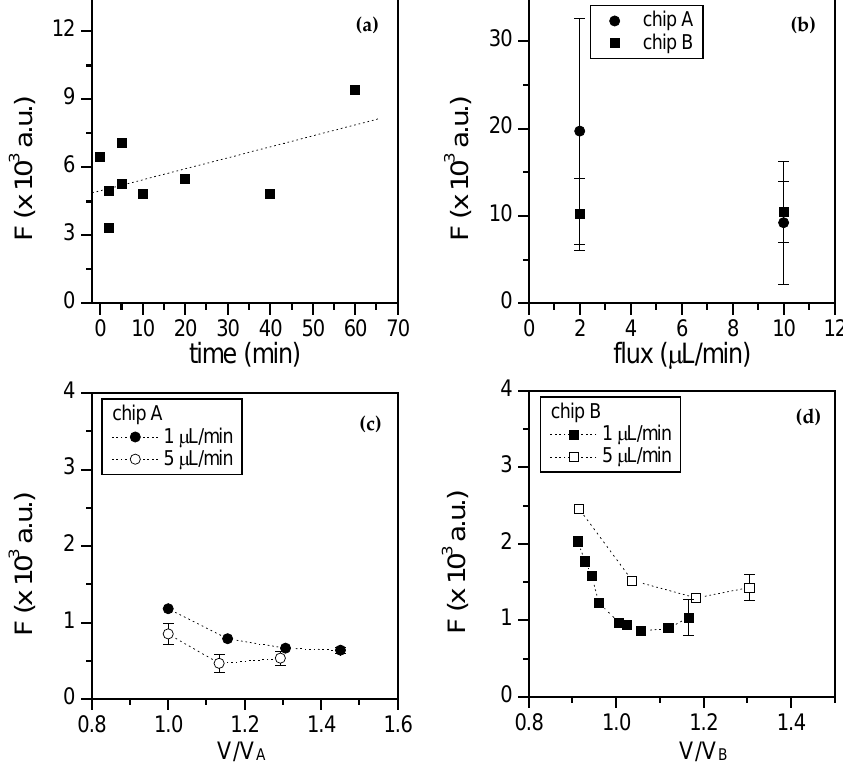
Figure 5 . Optimization of protocols from PDMS planar surfaces to spiral microdevices. Fluorescent miRNAs were used to assess functionalization parameters. Panel ( a ): optimization of silanization time. The microdevice is functionalized with a mixture of 0.1% APTMS and 0.9% PEG-s silane (named AS) in immersion at 60 °C for different times. An amount of 600 ng of fluorescent microRNAs diluted in water are then absorbed to microdevice AS surfaces and the resulting fluorescence is reported as a function of the silanization time. Panel ( b ): optimization of the flux speed during microRNA insertion. 3 ng/µL miR-1246-TAMRA was inserted either at 2 µL/min x 100 min or 10 µL/min x 20 min. Panels ( c , d ): optimization of washes speed after miR adsorption. A total of 600 ng of miR-1246-TAMRA, diluted in human plasma added with lysis bu ff er, were incubated on microdevices A (Panel ( c )) or B (Panel ( d )); then a wash with water is performed at di ff erent fluxes. Relative volumes are reported (i.e., referred to each chip